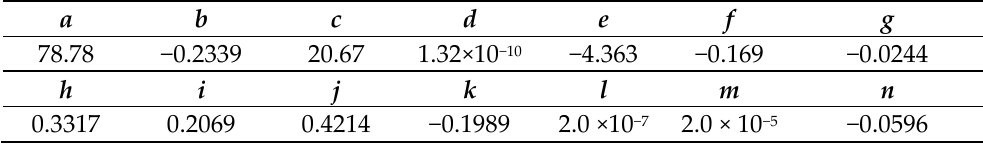
Table 5. Constant coefficients by regression from simulation results.